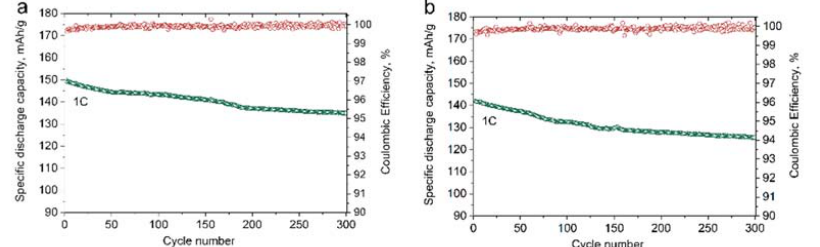
Figure 13. Capacity retention (green circles) and Coulombic efficiency (red circles) at 1C rate for the NMC811 samples CP_A ( a ) and CP7_MW3 ( b ) in full cells with the LTO anode. Table 4. Comparison of tap densities and basic electrochemical characteristics of the initial MW, CP, and mixed samples. Sample